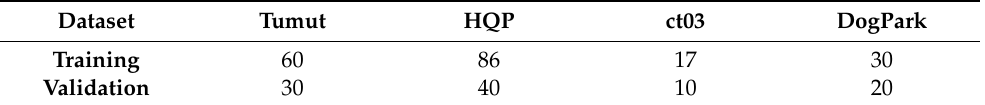
Table 1. The number of training and validation tree point cloud examples in each of our four